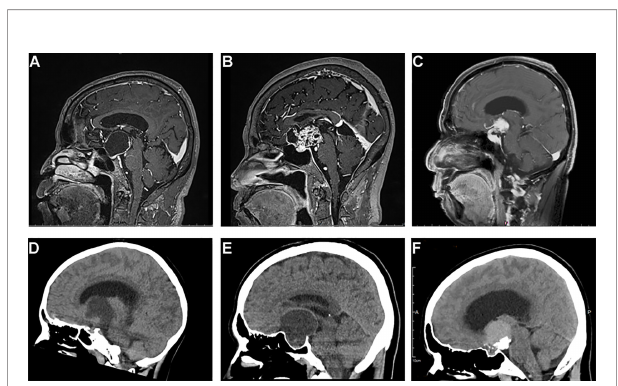
FIGURE 1 | Typical sagittal MRI and CT imaging pictures of craniopharyngiomas. (A – C) MR images, (A) cystic suprasellar – pseudointraventricular PCP, (B) mixed solid cystic infundibulo-tuberal ACP, and (C) solid infundibulo-tuberal PCP. (D – F) CT images, (D) a mixed solid-cystic case of PCP, no calci fi cation; (E) a mixed cystic-solid case of ACP showing peripheral eggshell calci fi cation; and (F) a solid case of ACP, big block popcorn calci fi